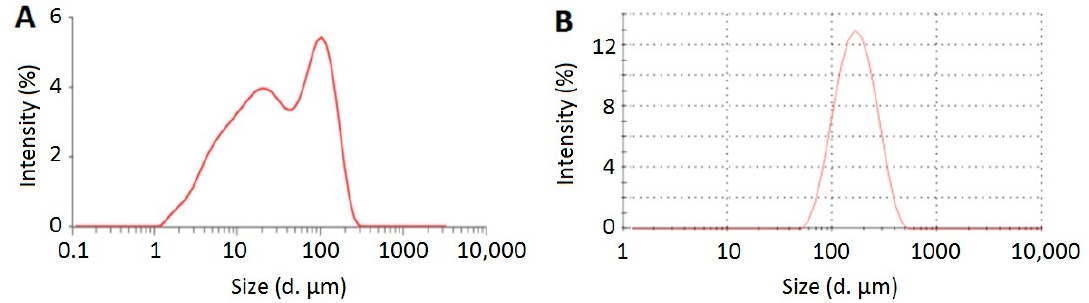
Figure 3. Particle size distributions of ( A )CLX crude powder and ( B )optimized CLX-NC.